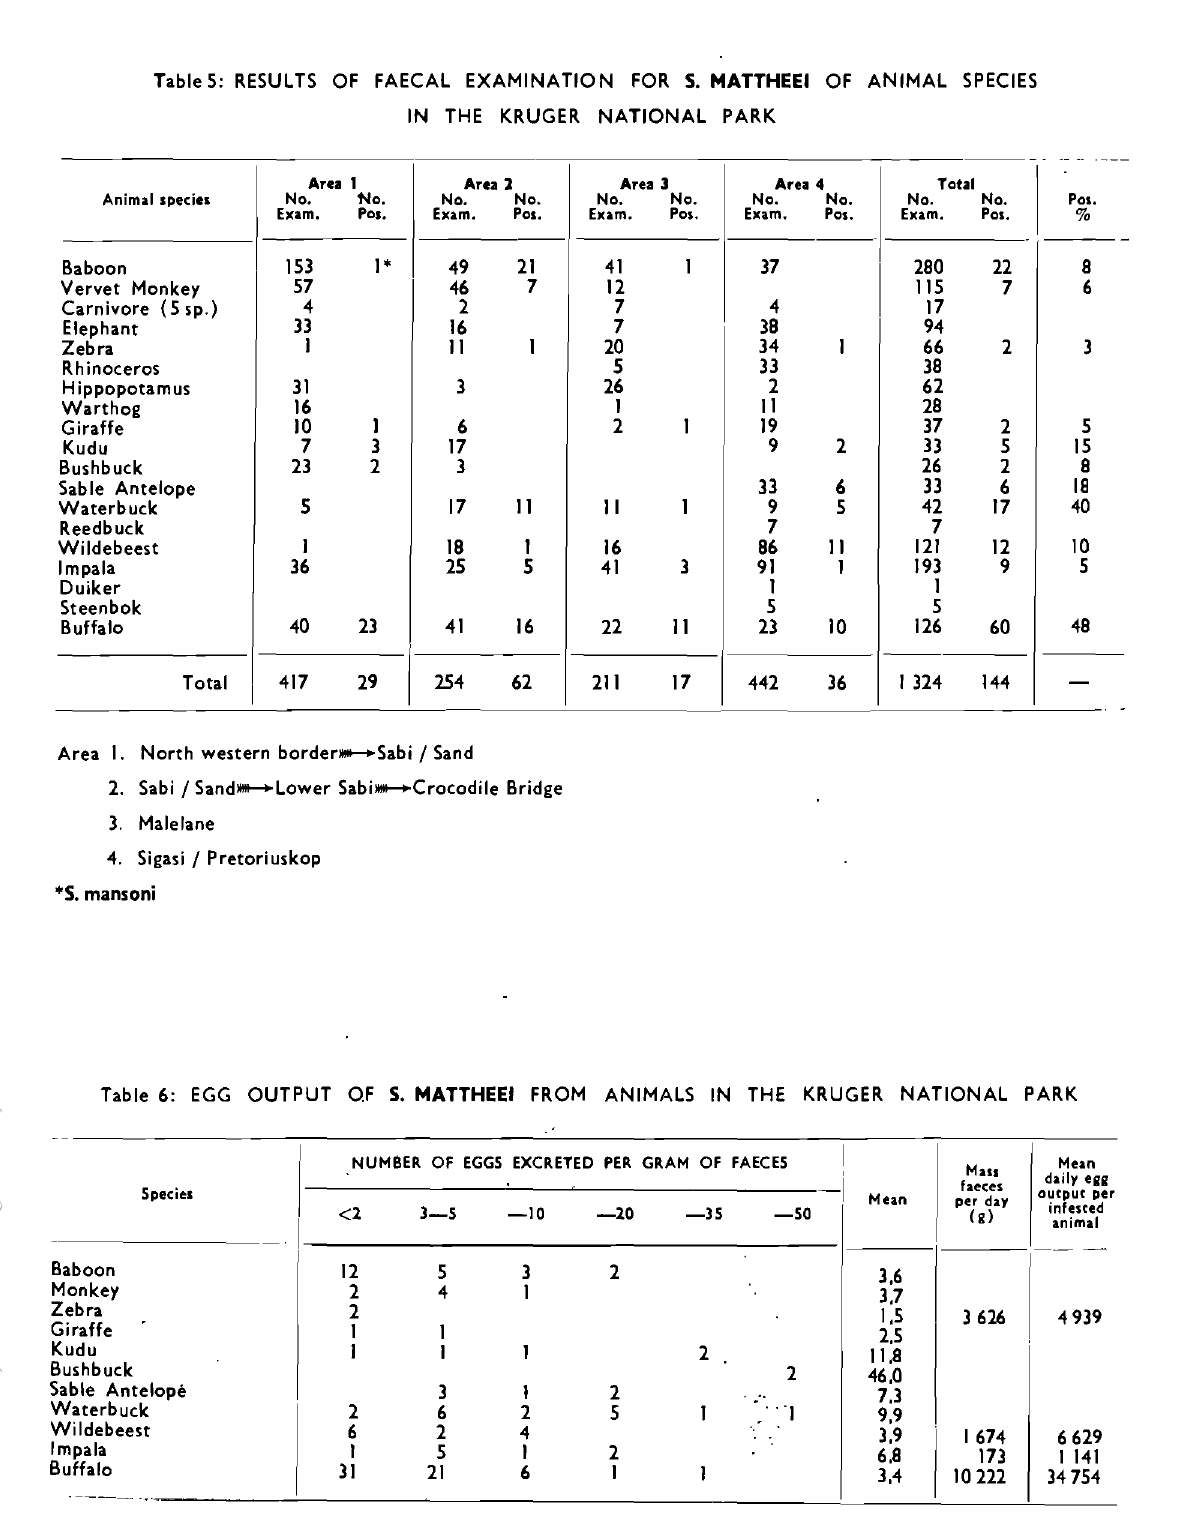
Table 6: EGG OUTPUT o.F S. MATTHEEI FROM ANIMALS IN THE KRUGER NATIONAL PARK